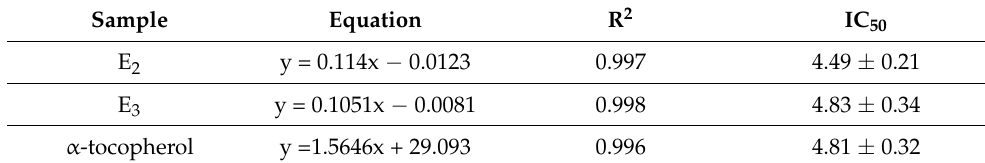
Table 10. IC 50 values (mg/mL) obtained using DPPH radical-scavenging activity.